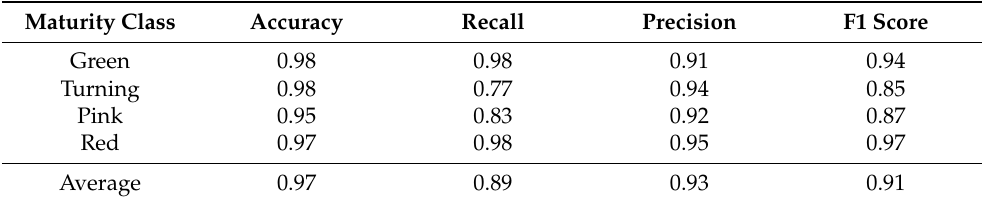
Table 1. Classification performance analysis of tomato maturity estimation model.